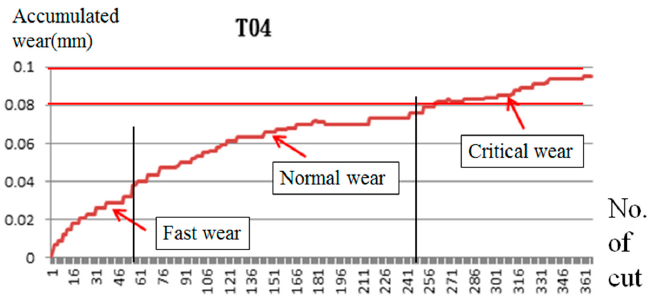
Figure 6. Tool wear vs. number of cuts of T04.